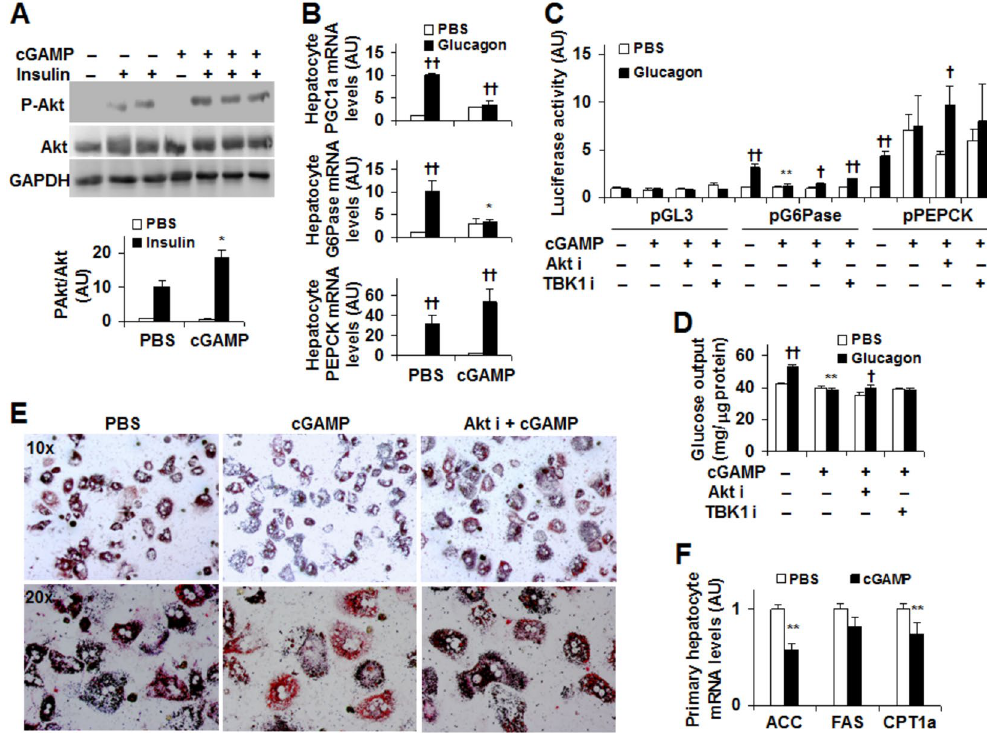
Figure 6. Exogenous cGAMP suppresses hepatocyte gluconeogenic events and fat deposition through pathway(s) involving Akt. ( A ) Hepatocyte insulin signaling. Cropped blots were displayed. Also, full-length blots were included in Supplemental Information (Figure S18). ( B ) Hepatocyte expression of genes for gluconeogenesis. ( C ) Transcription activity of G6Pase promoter and PEPCK promoter. ( D ) Hepatocyte glucose output (HGO). ( E ) Hepatocyte fat deposition. ( F ) Hepatocyte expression of genes related to fat metabolism. For A and B, primary hepatocytes were treated with exogenous cGAMP (20 µ g/ml) or PBS for 24 hr in the presence or absence of insulin (100 nM) for the last 30 min (A) or in the presence or absence of glucagon (100 nM) for last 4 hr (B). Insulin signaling was examined using Western blot analysis. Gene expression was examined using real-time PCR. For C, primary hepatocytes were transfected and treated as detailed in Methods. For C–E, primary hepatocytes were treated with cGAMP (20 µ g/ml) or PBS for 24 hr in the presence or absence of an Akt inhibitor (MK-2206, 1 µ M) or a TBK1 inhibitor (BX795, 1 µ M). HGO was measured as described in Methods. For E, to analyze fat deposition, the cells were also treated with or without palmitate (250 µ M) for 24 hr. At 1 hr prior to harvest, the cells were stained with Oil-Red-O. For F, primary mouse hepatocytes were treated with cGAMP (20 µ g/ml) or PBS for 24 hr. Hepatocyte mRNA levels were analyzed using real-time PCR. For bar graphs, data are means ± S.E. n = 4–8. AU, arbitrary unit. * P < 0.05 and ** P < 0.01 cGAMP vs. PBS under the same condition (Insulin-treated condition in A; Glucagon-treated conditions in B; Glucagon-treated conditions in the absence of Akt or TBK inhibition in C and D) for the same gene (in F); and † P < 0.05 and †† P < 0.01 Glucagon vs. PBS with the same treatment (PBS or cGAMP) for the same gene (in B) or glucagon-treated condition vs. PBS (in the absence of any other treatment or in the presence of cGAMP with Akt i or TBK1 i in C and D) for the same construct (in